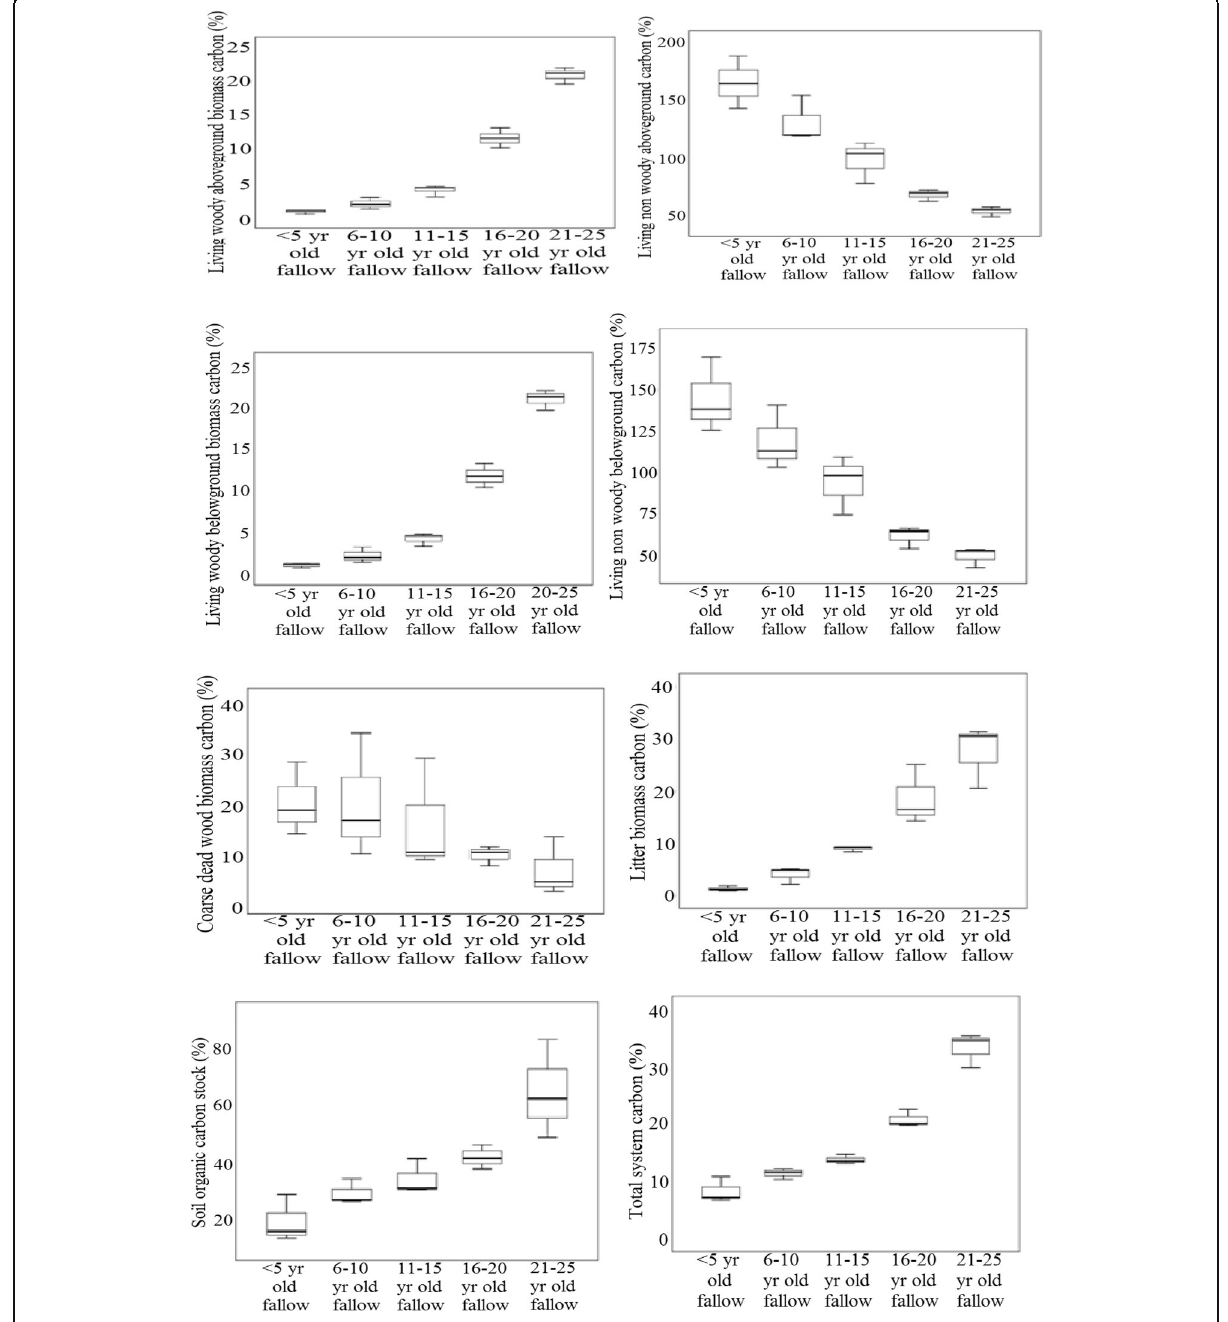
Fig. 5 Carbon stock recovery in different components of the jhum fallows relative to old-growth forest in the study area. Each bar represents upper, median, and lower values of carbon recovery and standard deviation of each corresponding fallow